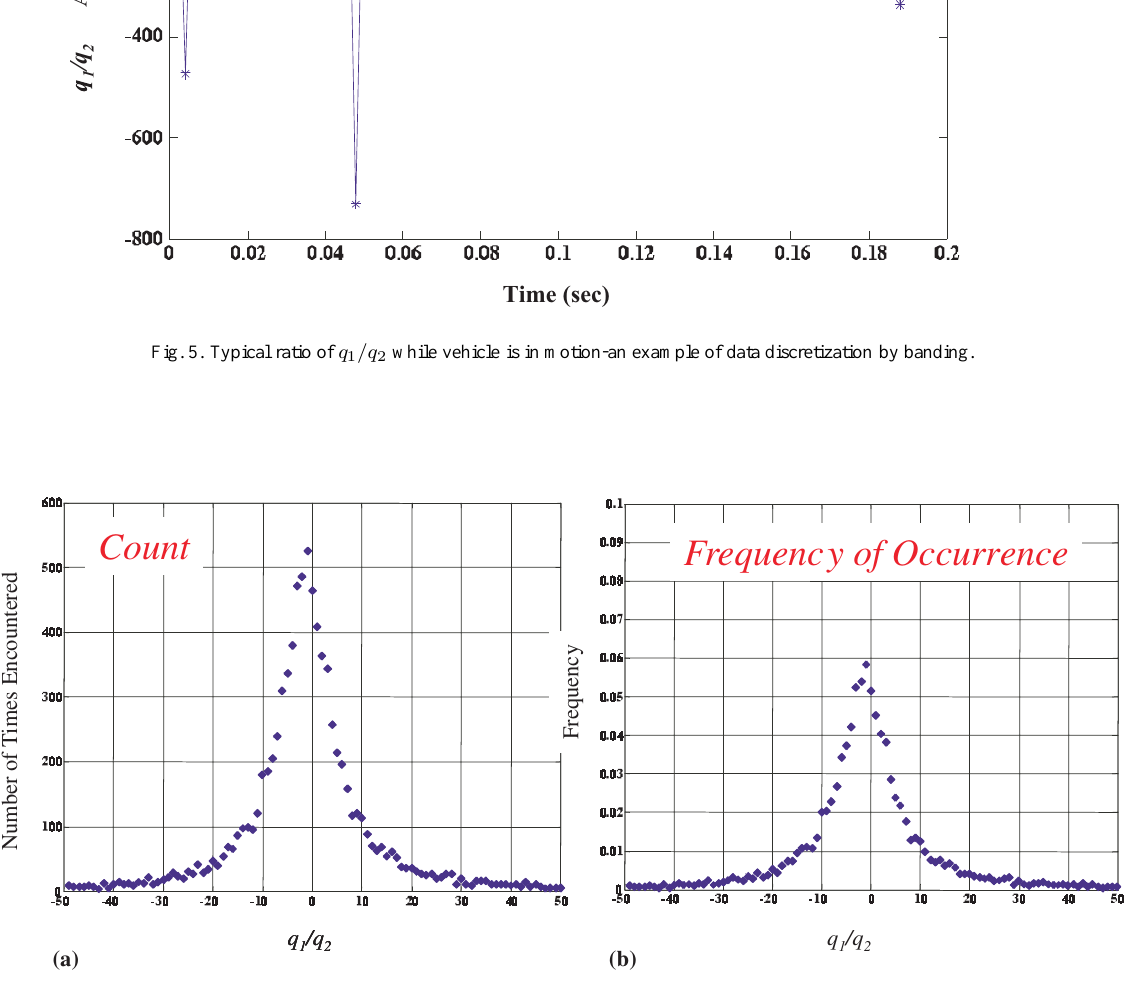
Fig. 6. Ratio of q 1 /q 2 for an M256 barrel traversing RRC-9 bump course: (a) number of occurrences in 9,000 samples and (b) frequency of